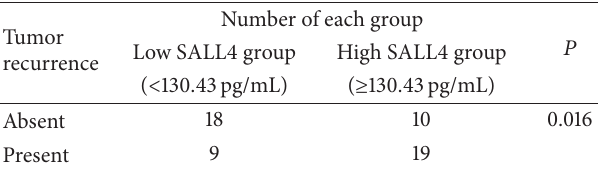
Table 5: The relationship between SALL4 expression and